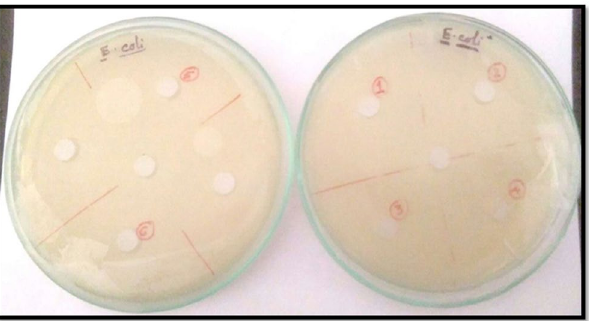
Figure 19. Antimicrobial activity analysis α -CD, β -CD on Gram-negative E. coli by Agar Cup method. No zone of inhibition is observed. Double distilled water is taken as the control. [Marker points (red) for the verified samples taken in the plates (1. SNP, 2. PEHB, 3. PEHA, 4. SNPA, 5. PEH, 6. SNPB) and Marker points (black) for the model organism taken in the plates].